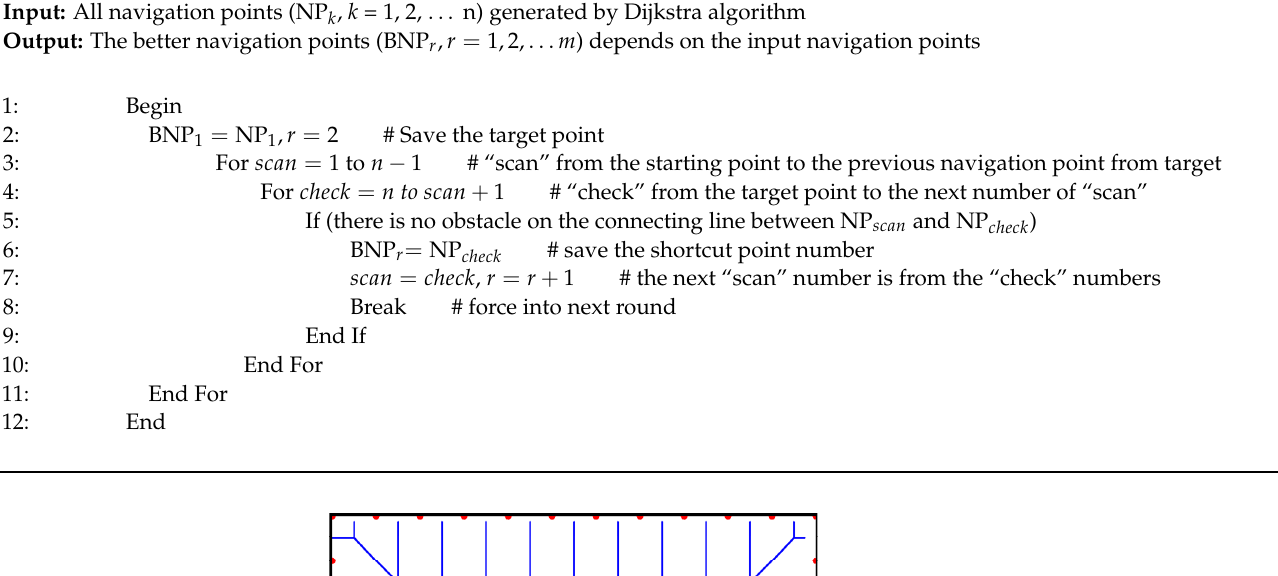
Algorithm 1. Path planning algorithm.